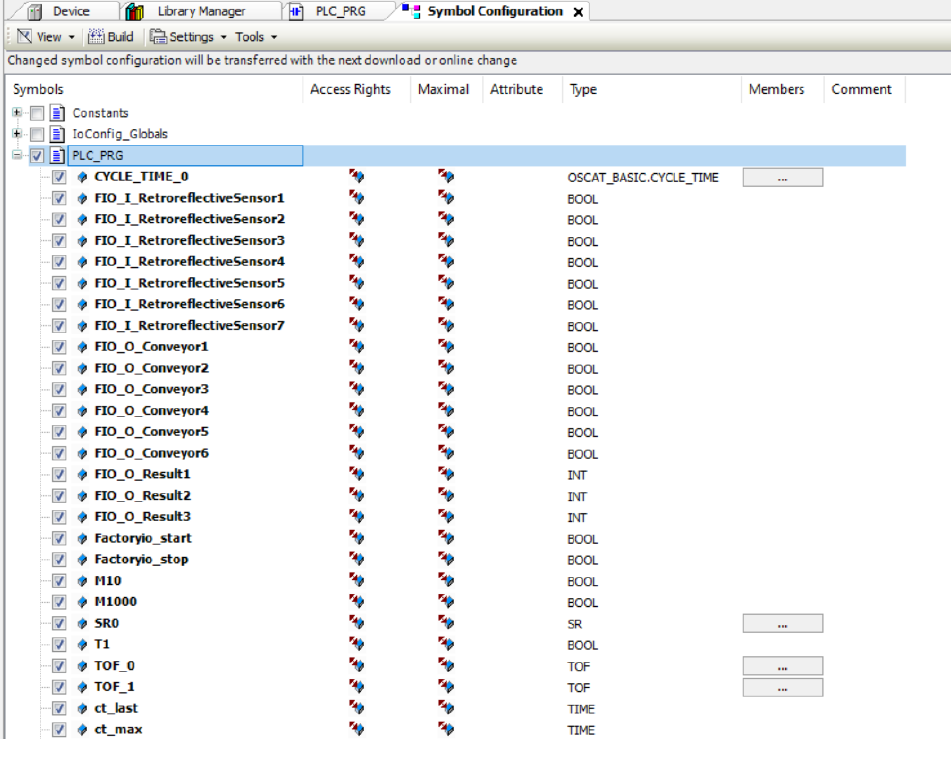
Figure 19. Symbol configuration.